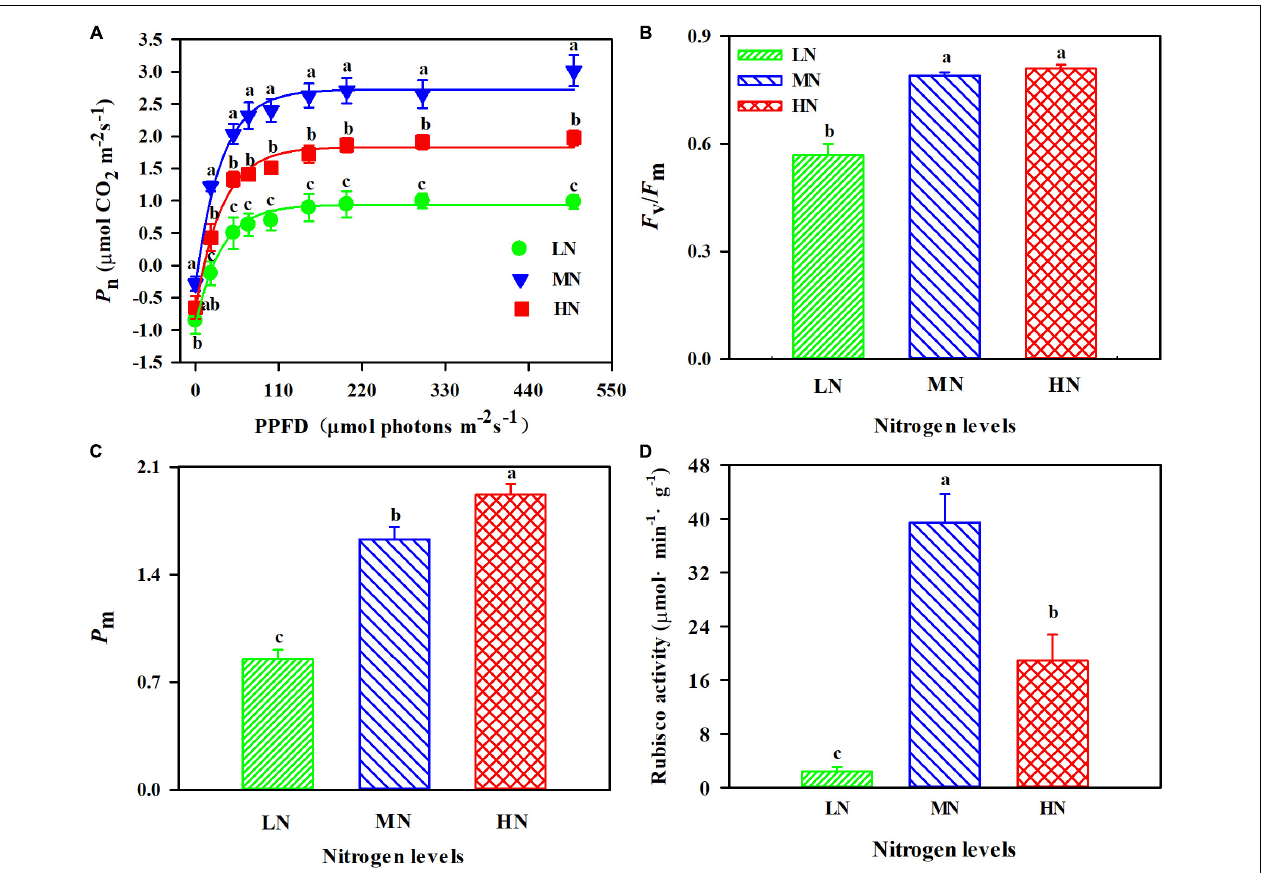
FIGURE 2 | (A) Response of net photosynthetic rate ( P n ) to photosynthetic photon flux density (PPFD) in Panax notoginseng grown under low nitrogen (LN, 0 kg hm – 2 ), moderate nitrogen (MN, 225 kg hm – 2 ), and high nitrogen (HN, 450 kg hm – 2 ). The effects of nitrogen regimes on PSI (B) , PSII (C) , and Rubisco activity (D) of P. notoginseng . P m is the maximum photo-oxidation P700 + ; F v / F m is the maximum efficiency of PSII photochemistry. Values for each point were mean ± SD ( n = 5). Different letters among nitrogen regimes indicate significant difference ( p < 0.05).